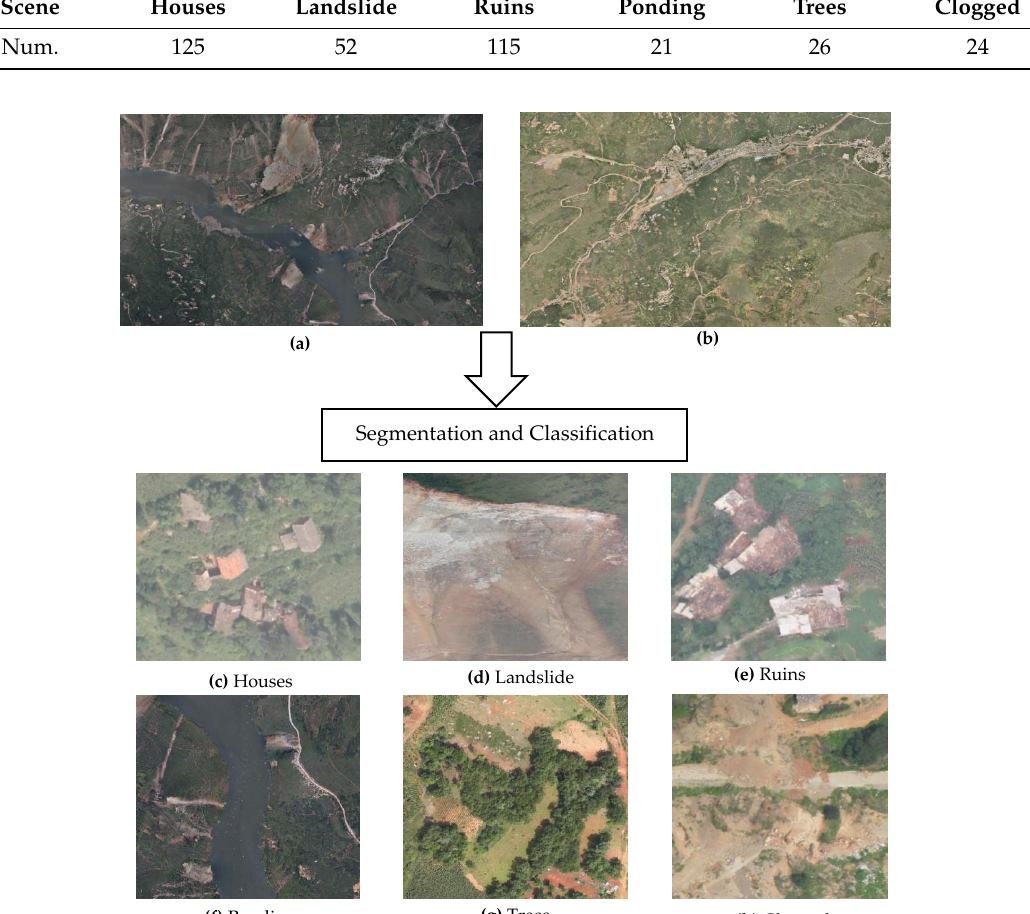
Figure 2. Results of segmentation and classification. Image ( a ) is of part of Niulan river and image ( b ) is of part of Longtou mountain. Segmented and classified postearthquake scenes: ( c ) houses, ( d ) landslide, ( e ) ruins, ( f ) ponding, ( g ) trees and ( h )